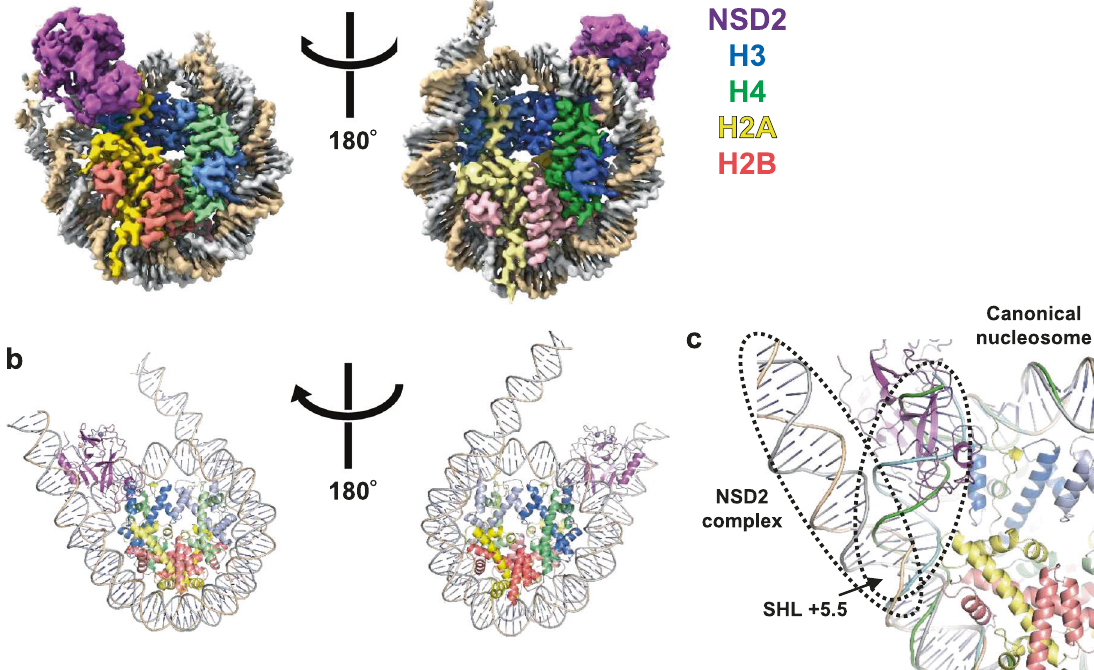
Fig. 1 Overall structure. Unless stated otherwise, proteins are colored as follows: NSD2, magenta; H3, blue; H4, green; H2A, pink; and H2B, yellow. a Density map and b ribbon model, two views related by 180° rotation. c Superposition of the current NSD2-nucleosome structure with that of a canonical nucleosome (PDB 1KX5). Duplex DNA in the NSD2 complex stretches straight up to approximately SHL + 5.5, resulting in its partial unwrapping.